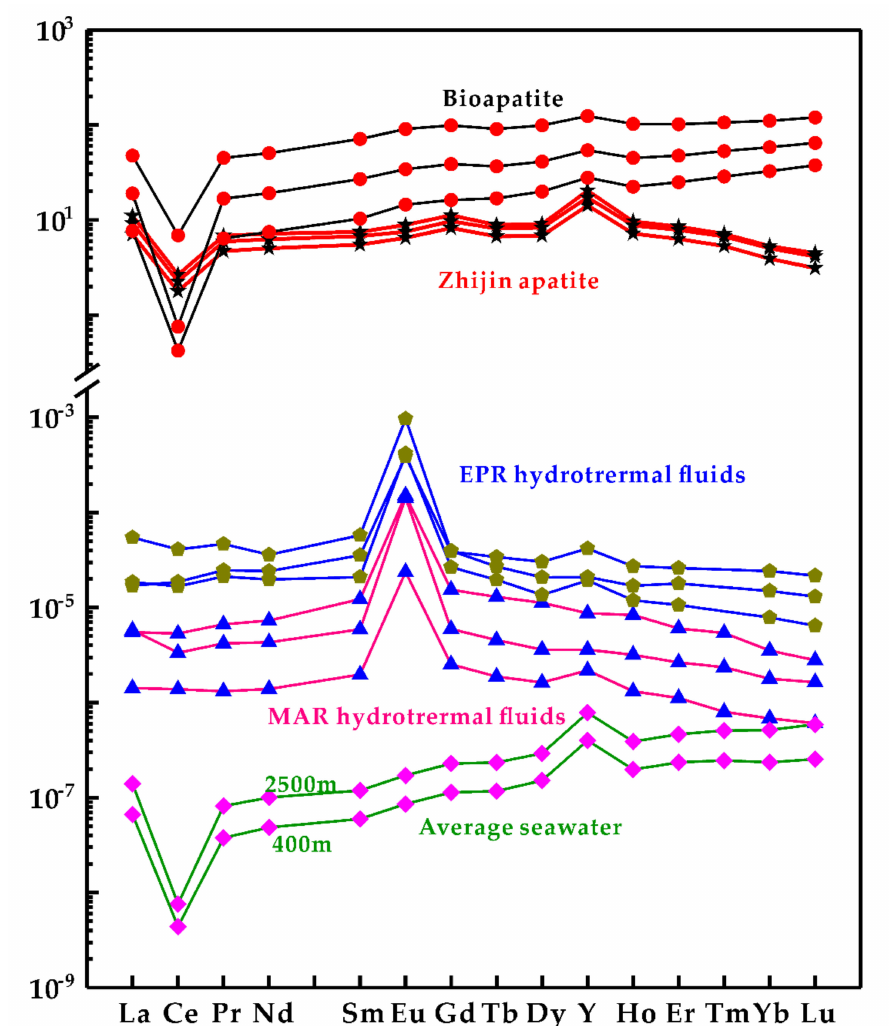
Figure 6. PAAS-normalized REY patterns of di ff erent sources: Zhijin apatite; East Pacific Ridge (EPR) hydrothermal systems [19]; hydrothermal fluids from the Mid-Atlantic Ridge (MAR) [15]; average seawater (2500 m and 400 m depth, [52]); bioapatite in deep-sea sediments